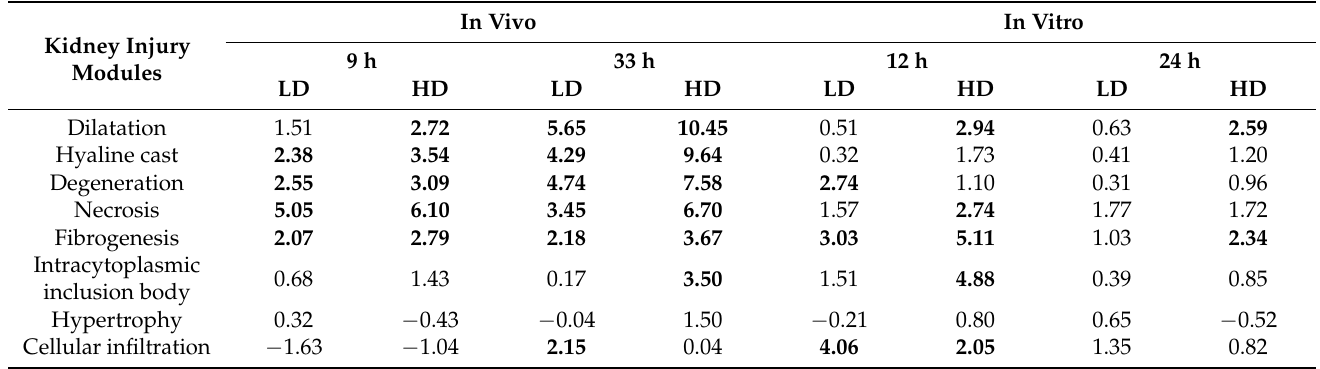
Table 4. Activation scores for kidney injury modules based on gene expression data collected at different doses and exposure times during the in vivo and in vitro guinea pig studies. Bold font indicates values above the 2.0 significance threshold. HD, high dose; LD, low